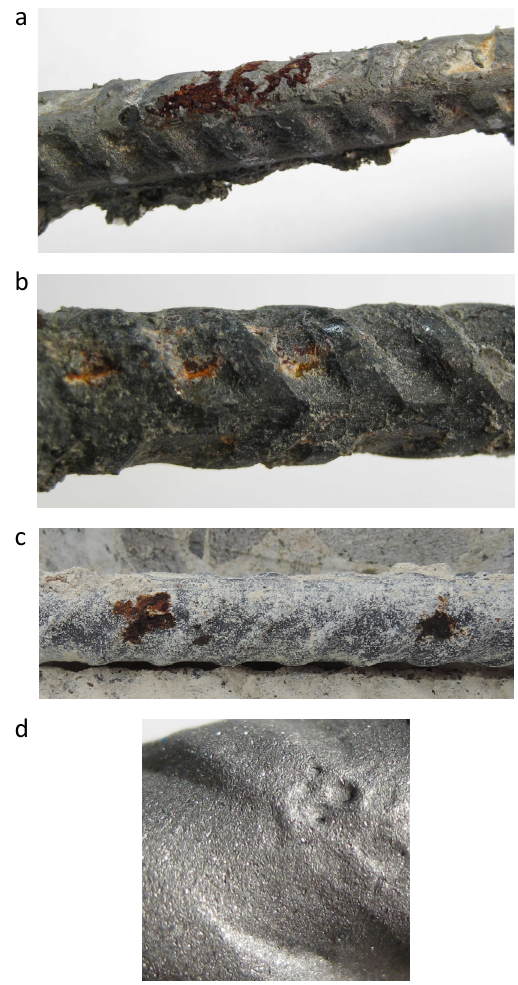
Figure 4. Example of corrosion products autopsy: (a) red‐brown corrosion product, (b) corrosion products between the ribs, (c) red‐ brown corrosion product (Left), black corrosion product (right), (d) corrosion pits on rebar ribs, visible after removal of corrosion products by sandblasting. (Courtesy of U.